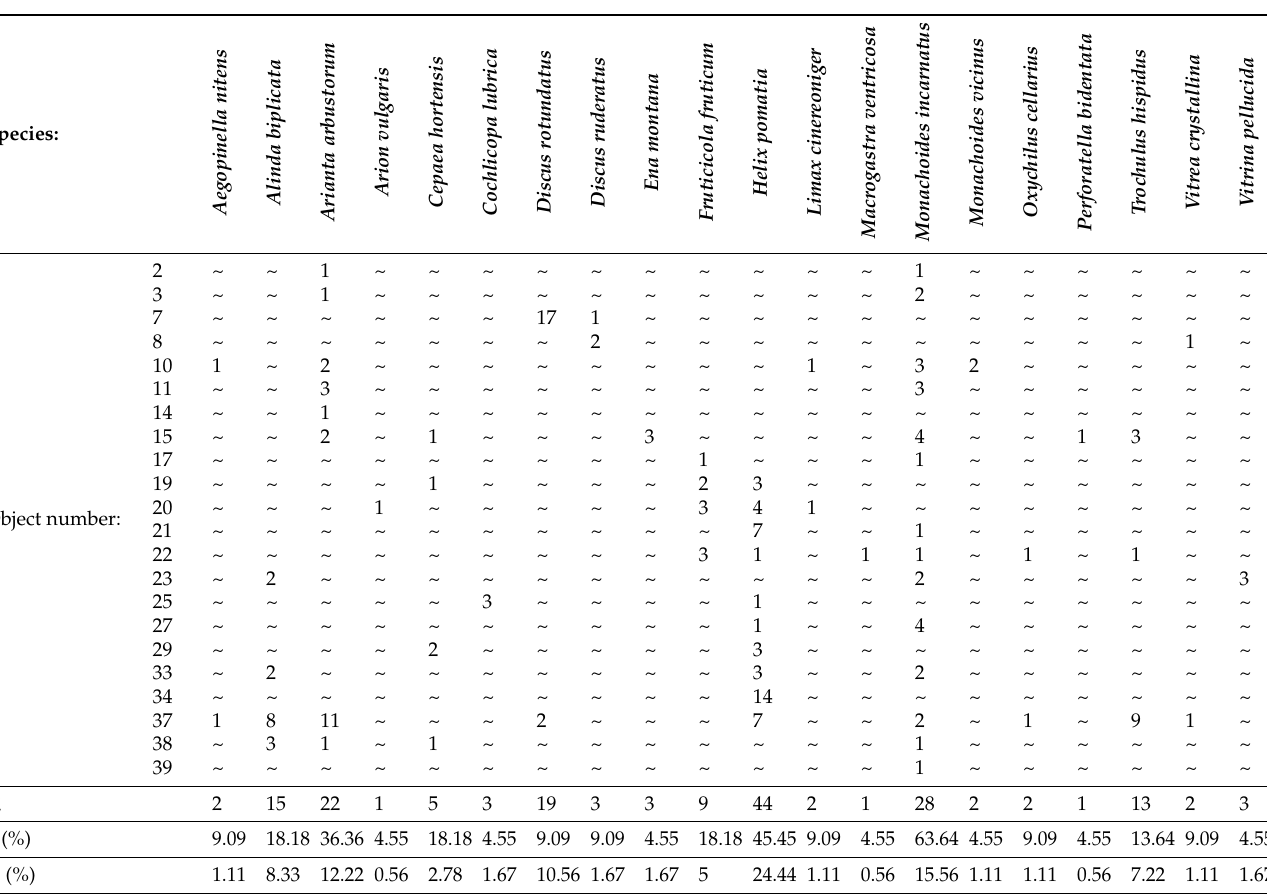
Table A7. Species of land snails (Gastropoda) and their abundances in each SA-CEFs in 2014, F—frequency in %, D—dominance in